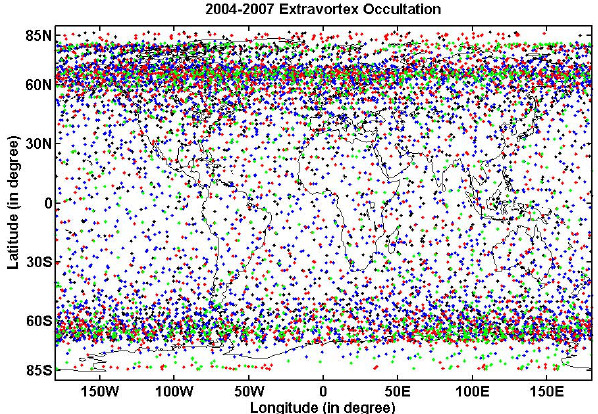
Fig. 2. The locations of 8703 extravortex ACE-FTS occultations during the period February 2004 to August 2007 are indicated by coloured markers. Each colour denotes a different year; black: 2004, blue: 2005, red: 2006 and green: